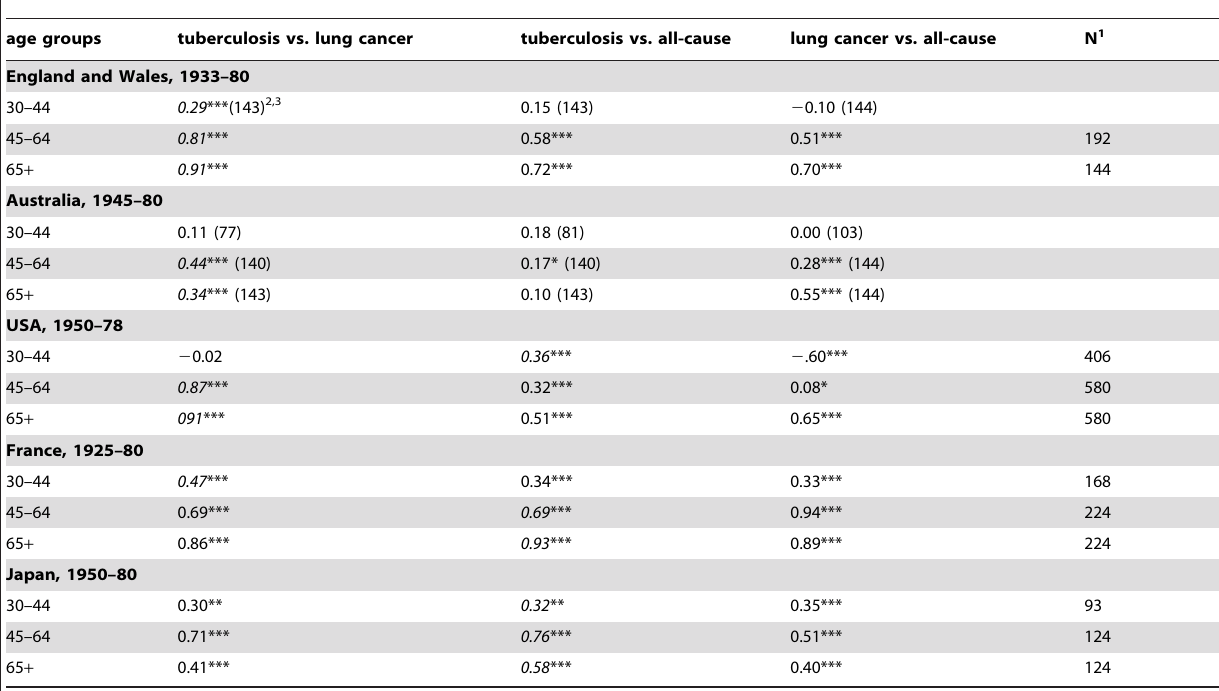
Table 4. Pearson co-efficients (r) of correlation between sex ratios of tuberculosis, lung cancer, and all-cause mortality.